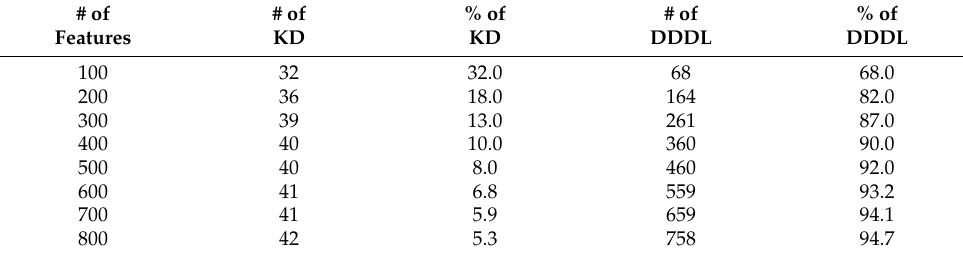
Table 4. Number and percentage of KD and DDDL in features with the highest IG